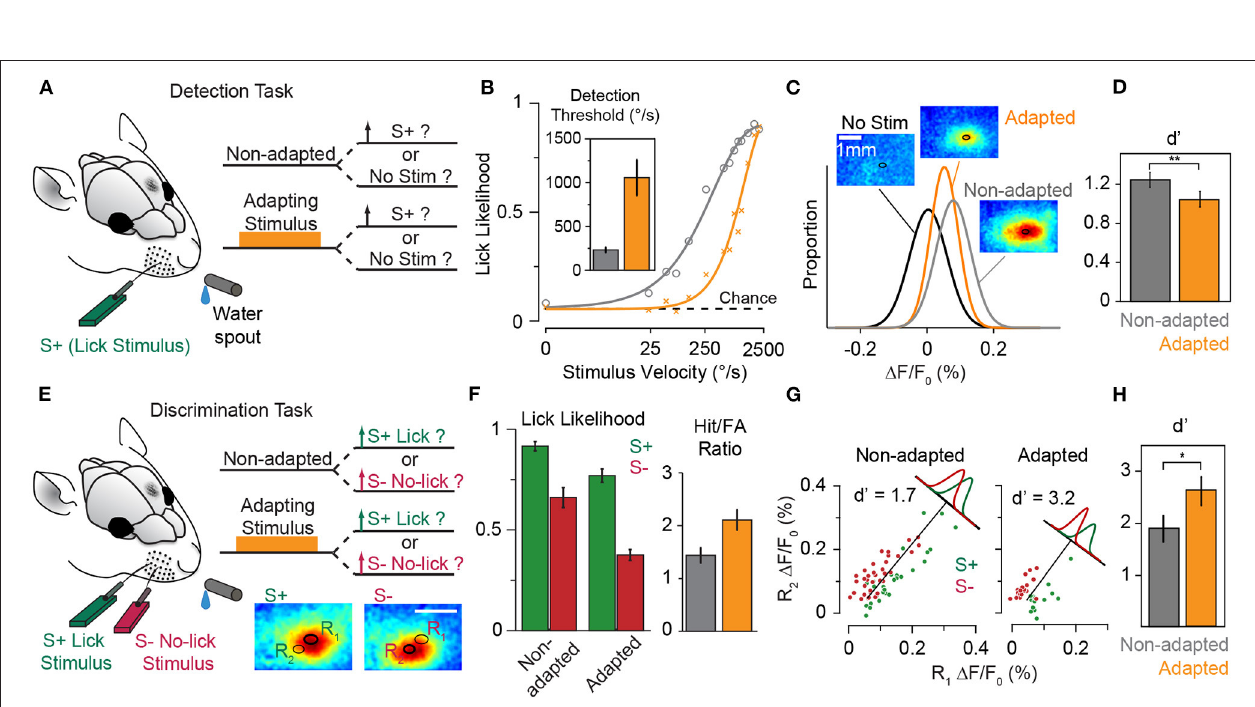
FIGURE 10 | Adaptation decreases stimulus detectability while improves discriminability. (A) Detection task: a piezoelectric actuator was placed on a single whisker, and a variable velocity probe stimulus (S+) was presented at a randomised time. The probe was preceded by an adapting stimulus on 50% of trials. Animals had a 1 s window following the stimulus in which to emit a lick response to receive a water reward. (B) Psychometric curve—response likelihood as a function of stimulus—averaged across all animals, for the non-adapted (grey) and adapted (amber) conditions. The black dashed line indicates the chance performance level (licks in catch trials). The inset depicts that behavioural detection thresholds are increased with adaptation. Each bar represents the perceptual detection threshold, measured as the 50% point of the sigmoidal fit (M 50 ). Error bars represent s.e.m. (C) Ideal observer of neuronal activity. Neural activity was measured using voltage-sensitive dye (VSD) imaging of cortex within an approximately barrel-sized (300–500 µm in diameter) region of interest (ROI) time-averaged over 10–25 ms after stimulus onset. The ROI was defined as the 98% height contour of the 2D Gaussian fit to the trial-averaged non-adapted responses. The insets show the corresponding trial-averaged VSD images for no-stimulus (pre-stimulus, in black), non-adapted (grey), and adapted (amber) with the ROIs outlined in black. An average fluorescence within the ROI was extracted from each trial for ideal observer analysis. (D) The stimulus detectability of ideal observer decreased with adaptation. The d’ value, a measure of the separation of stimulus vs. no-stimulus distributions, decreased with adaptation ( p <0.005, n = 18, paired t -test). Error bars represent s.e.m. (E) Discrimination task: two piezoelectric actuators were used to stimulate two nearby whiskers. On a given trial either the whisker associated with the S+ (lick stimulus) or the nearby whisker associated with the S- (no-lick stimulus) was deflected with equal probability. Whisker deflection was at a fixed supra-threshold velocity. Animals were rewarded for responses to the S+ stimulus (hit), but were penalised with a time-out for responses to deflections of the S- whisker (false alarm, or FA). The insets depict neuronal responses to the two whisker stimuli (S+ and S-). Two responses were calculated for each single trial: the average fluorescence within the principal barrel area (bold ellipse), and that within the adjacent barrel area (thin ellipse) using the same method as in (C) . The white scale bar in the inset represents 1 mm. (F) Adaptation improves the behavioural discriminability characterised in terms of the ratio of the proportion of hit trials to FA trials. (G) Example of linear discriminant analysis of neuronal responses to S+ and S- in the non-adapted (left panel) and adapted (right panel) conditions. Each data point corresponds to a single trial with the response from ROI associated with S+ principal whisker (ordinate) vs. the response from the ROI associated with S- principal whisker (abscissa). Neuronal response distributions to S+ and S- were obtained by projection of data points onto the axis orthogonal to the best discriminant line. The d’